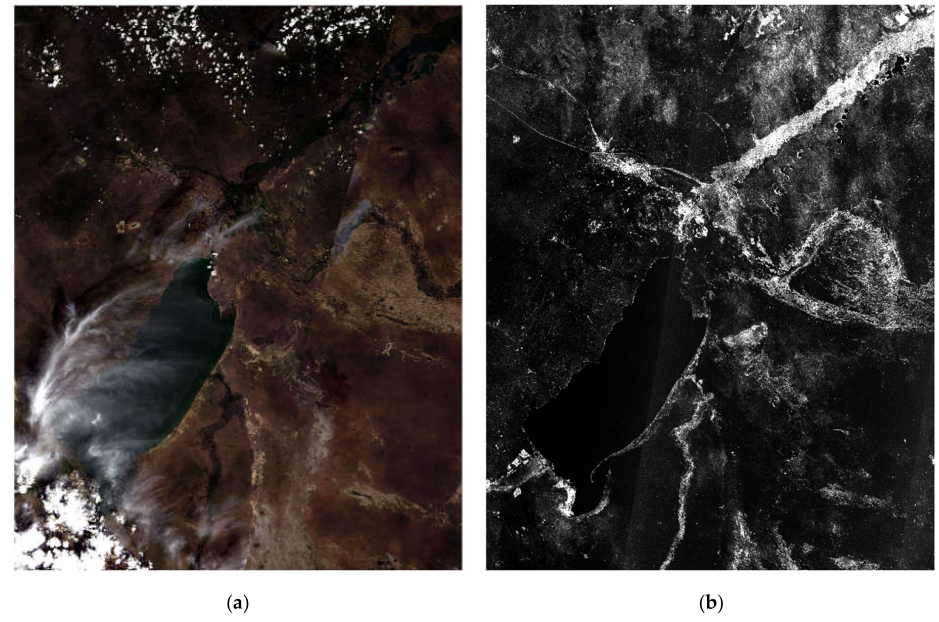
Figure 3. ( a ) MS image after data pre-processing (Landsat-8, 4, 3 and 2 bands); ( b ) MS image after data pre-processing (Sentinal-1, VH